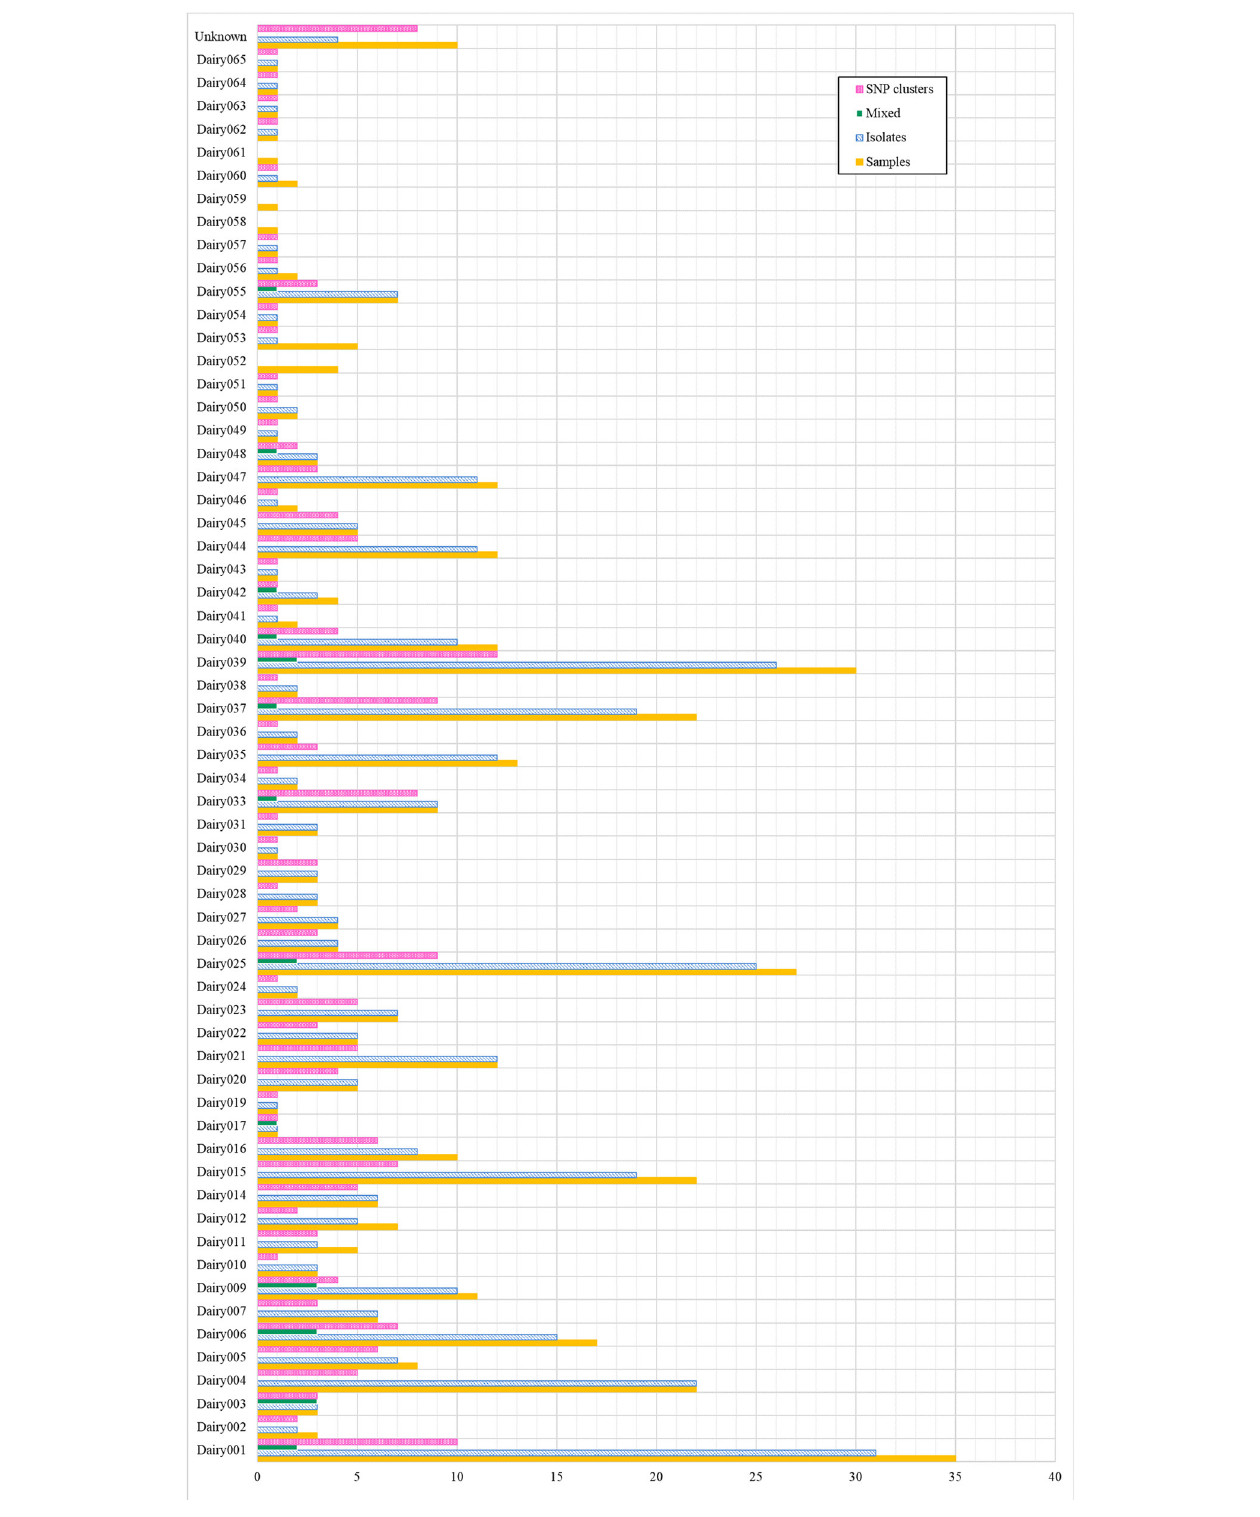
FIGURE 2 | Baja California dairies with positive detection of M. bovis . For each dairy, the figure indicates the total number of samples, isolates and SNP clusters. “Mixed” refers to isolates that had a high proportion ( ≥ 50%) of ambiguous SNP calls, indicating the presence of more than one genotype. “Unknown” refers to dairies that were not possible to trace